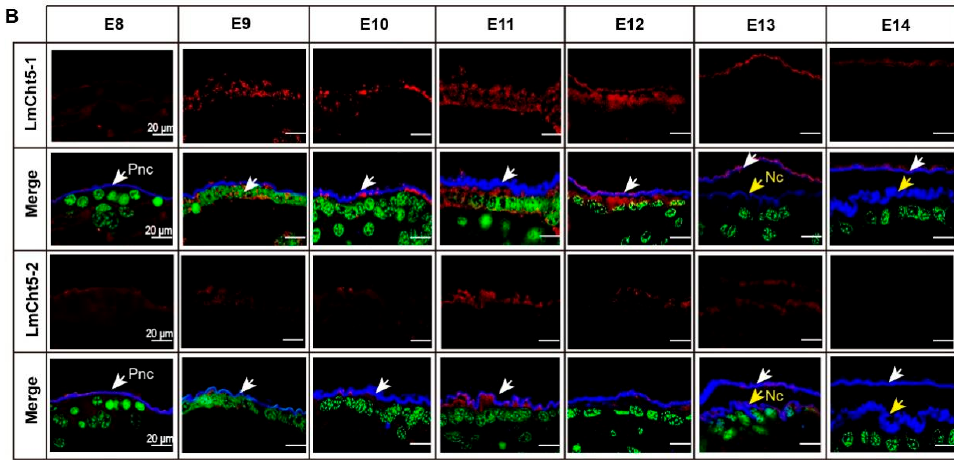
Figure 3. Localization of LmCht5-1 and LmCht5-2 in the degradation of the serosal cuticle and pro-nymphal cuticle. Sections (5 μ m) of eggs from E7 to E13 were visualized with SYTOX ® Green to show the nucleus of cuticle cells (green) and FB28 to counterstain chitin (blue) both in the serosal cuticle ( A ) and the pro-nymphal cuticle ( B ). Localization of LmCht5-1 and LmCht5-2 was previously identified by polyclonal antibody detection with the aid of helper Cy3-AffiniPure donkey anti-rabbit antibody (red). LmCht5-1 is expressed in a highly scattered way in the coarser upper serosal cuticle at E9, while LmCht5-2 is mainly expressed in the fine structure of the lower serosal cuticle from E7 to E9. During pro-nymphal cuticle degradation, LmCht5-1 is first located in the cuticle cell at E9 and then expressed in the layer structure of the procuticle during E10 to E13, while LmCht5-2 kept a lower expression level in the procuticle degradation process. The white line shows the coarse layer in the upper part, while the yellow line shows the fine layer in the lower part. Pnc: Pro-nymphal cuticle; NC: first instar nymphal cuticle.